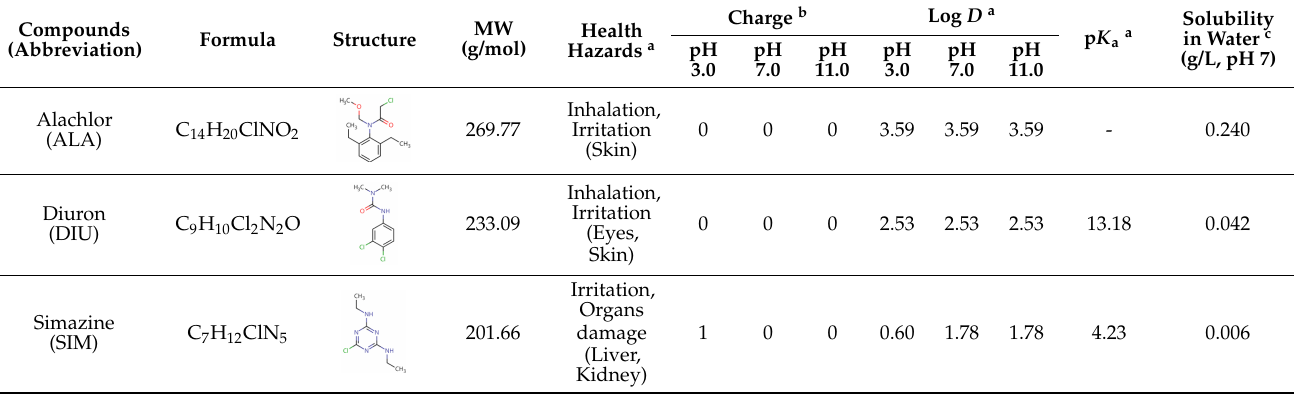
Table 1. Physicochemical Characteristics of the